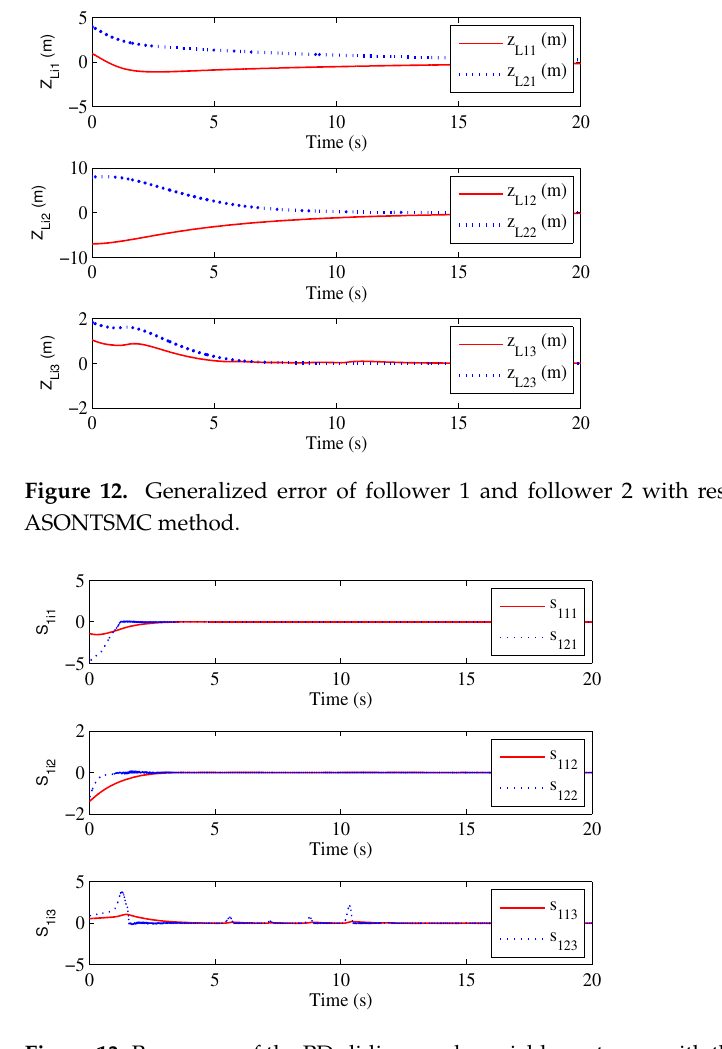
Figure 13. Responses of the PD sliding-mode variable vector s 1 i with the ASONTSMC